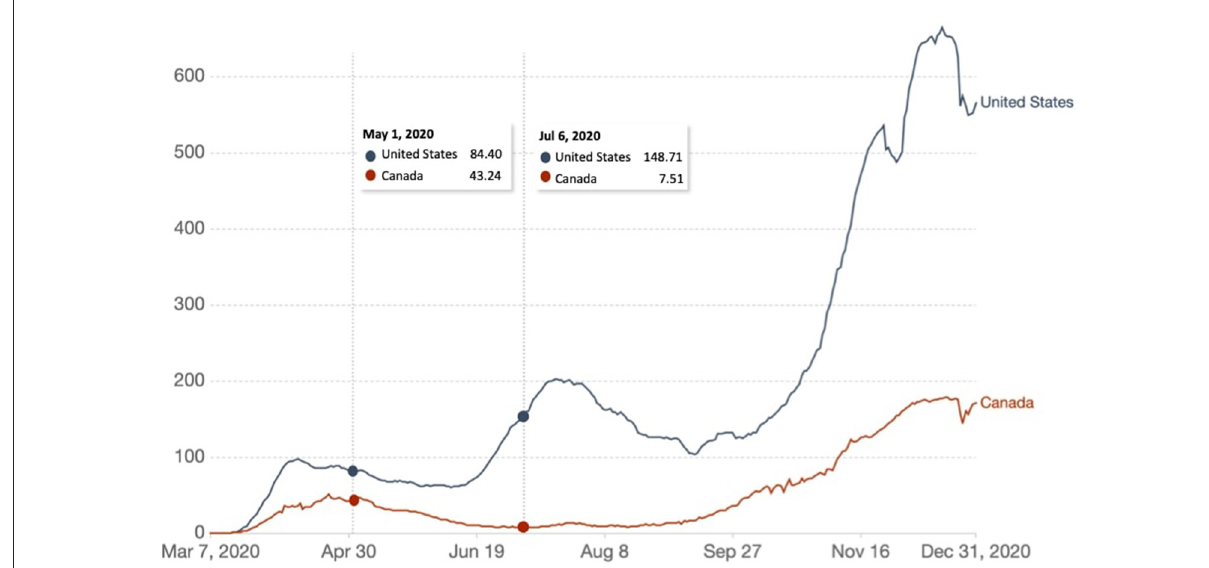
FIGURE1 Weekly number of new confirmed COVID-19 cases per million people in the United States and Canada. The survey data was collected from May 1 to 4, 2020 ( n = 1,019) and from July 6 to 10 ( n = 3,923). Source: COVID-19 Data Repository by the Center for Systems Science and Engineering (CSSE) at Johns Hopkins University (20) via Our World in